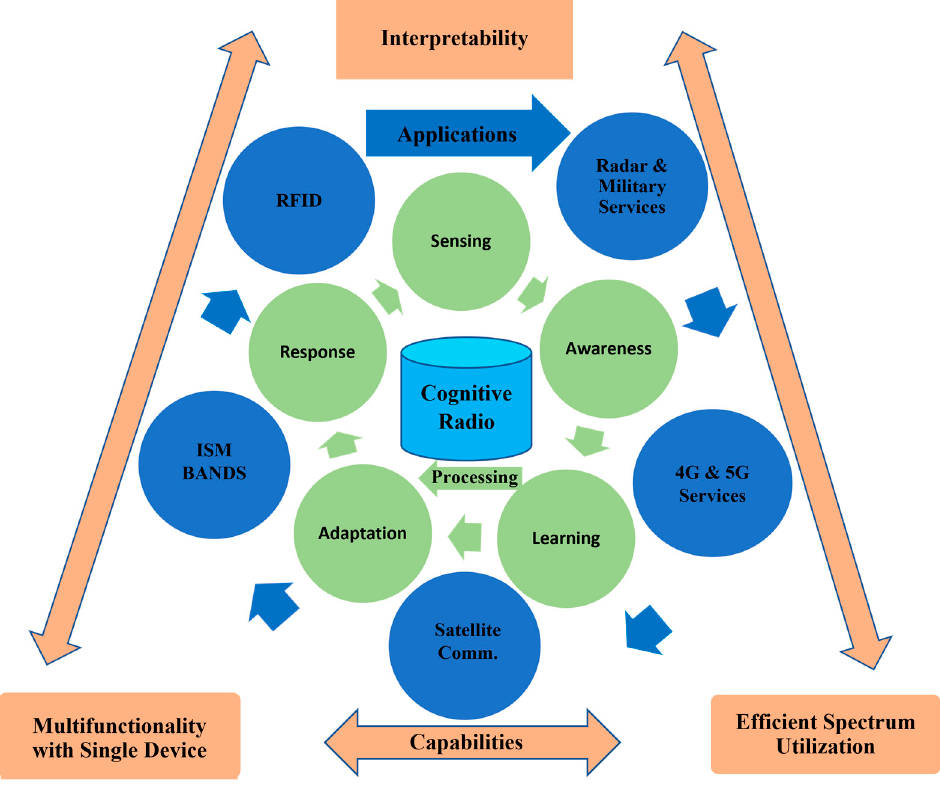
Figure 1. Cognitive radio